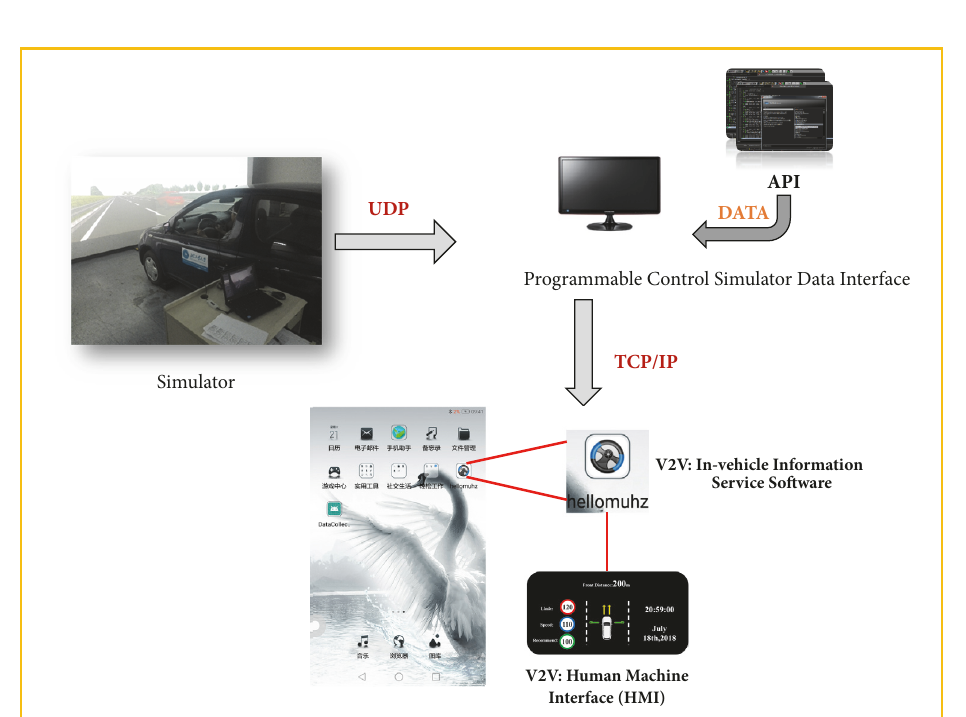
Figure 2: Simulation platform of connected vehicle environment.